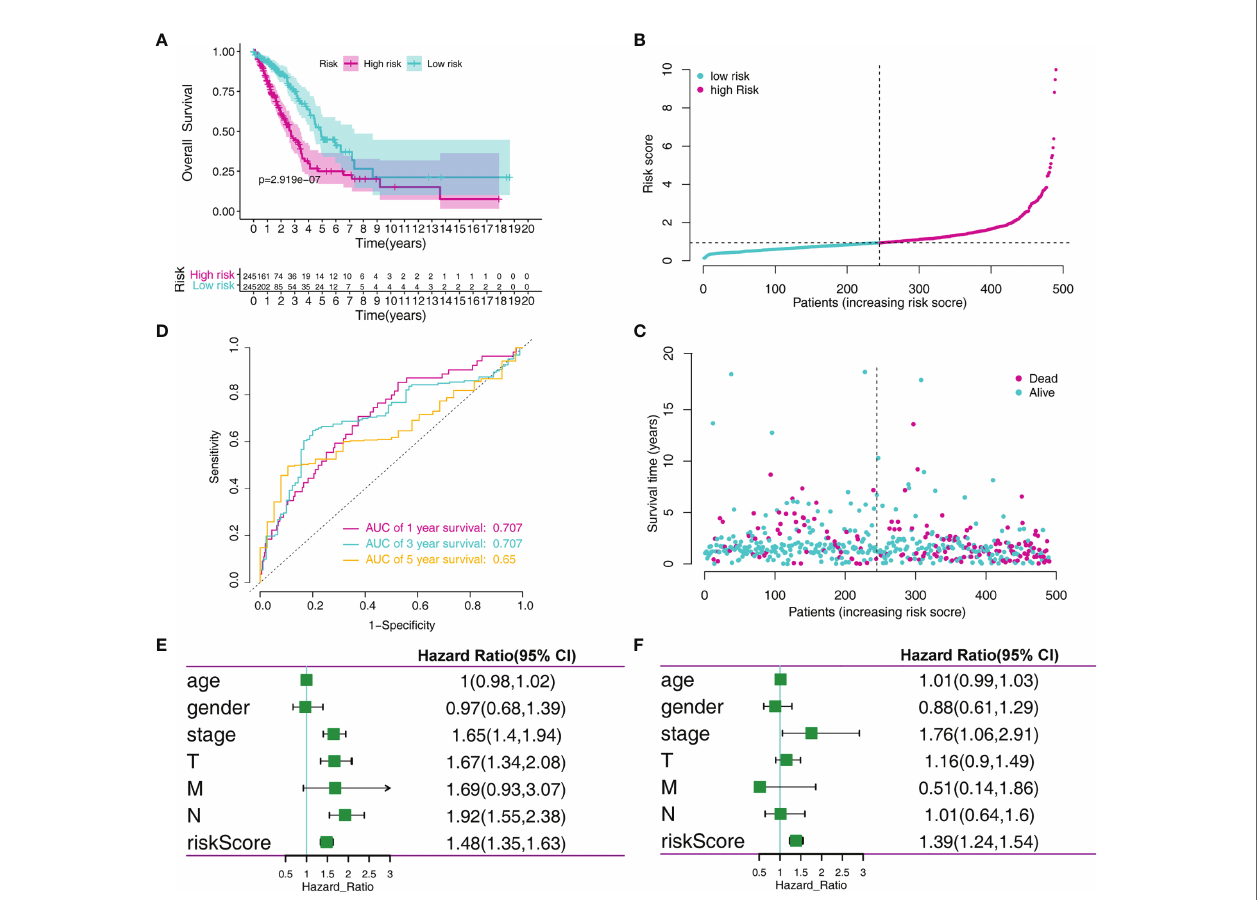
FIGURE 3 | MRGs-based risk signature evaluation using the training set. (A) Kaplan-Meier survival analysis revealed the difference in survival rate between high- and low-risk patients. (B) Time-dependent ROC curve analysis for 1-, 3-, and 5-year predictions of overall survival using the MRG-based signature. (C) Risk score distribution of patients with the overall survival and signature. (D) Overall survival scatter plots for LADC patients. (E) Univariate Cox analyses of the MRG signature and clinical variables. (F) Multivariate Cox analyses of the MRG signature and clinical